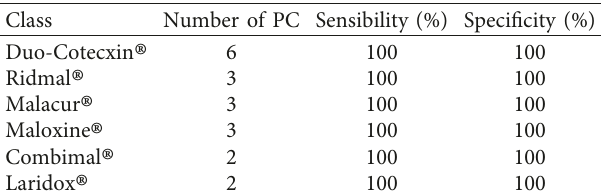
Table 2: classical SIMCA model